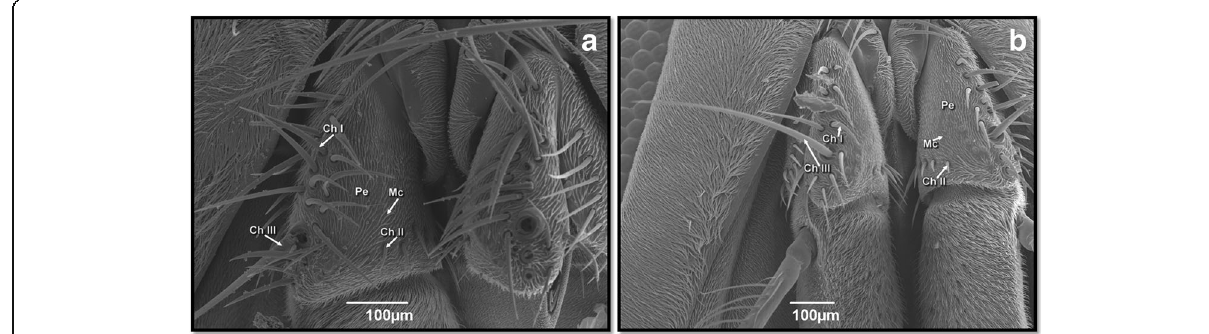
Fig. 3 Scanning electron micrographs showing the cuticular surface of pedicel in both genders of Mesembrinella bellardiana : a female (× 190), b male (× 140). Pe = pedicel; ChI-ChIII = chaetic sensilla I, II and III; Mc = microtrichia